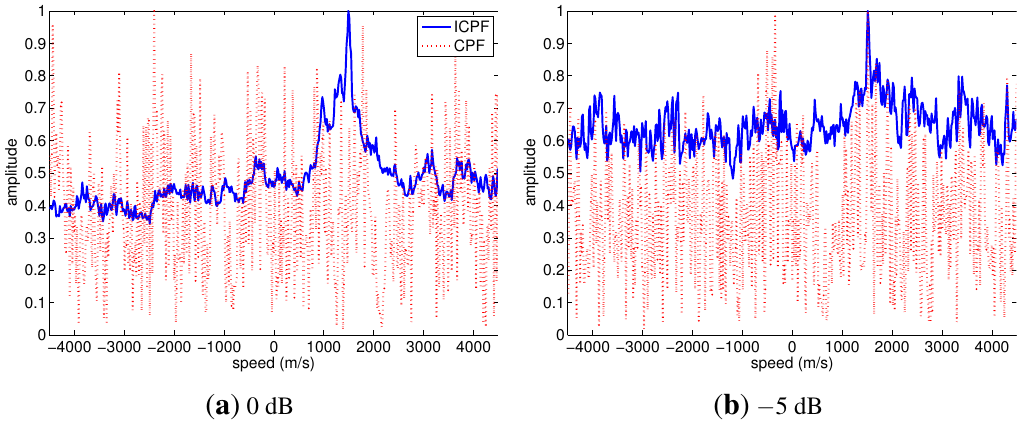
Figure 6. CPF and ICPF of the radar echo in different SNR